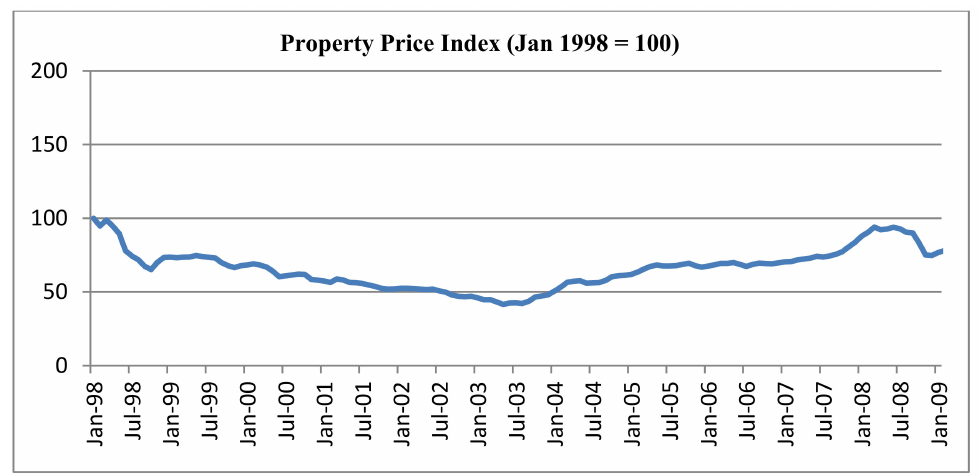
Figure 2. Price level of Hong Kong Island housing market 1998–2009. Source: Hong Kong Island Residential Price Index developed by the Department of Real Estate and Construction, the University of Hong Kong.